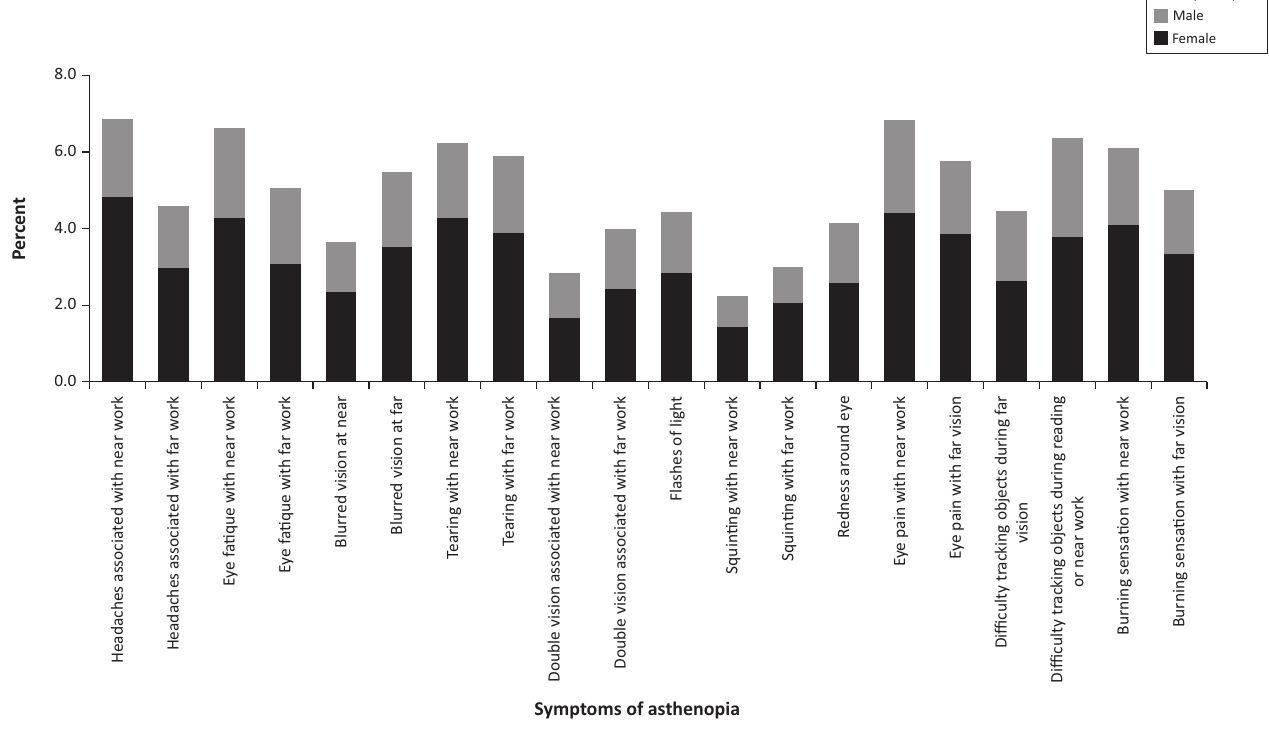
FIGURE 1: Gender distribution of asthenopic